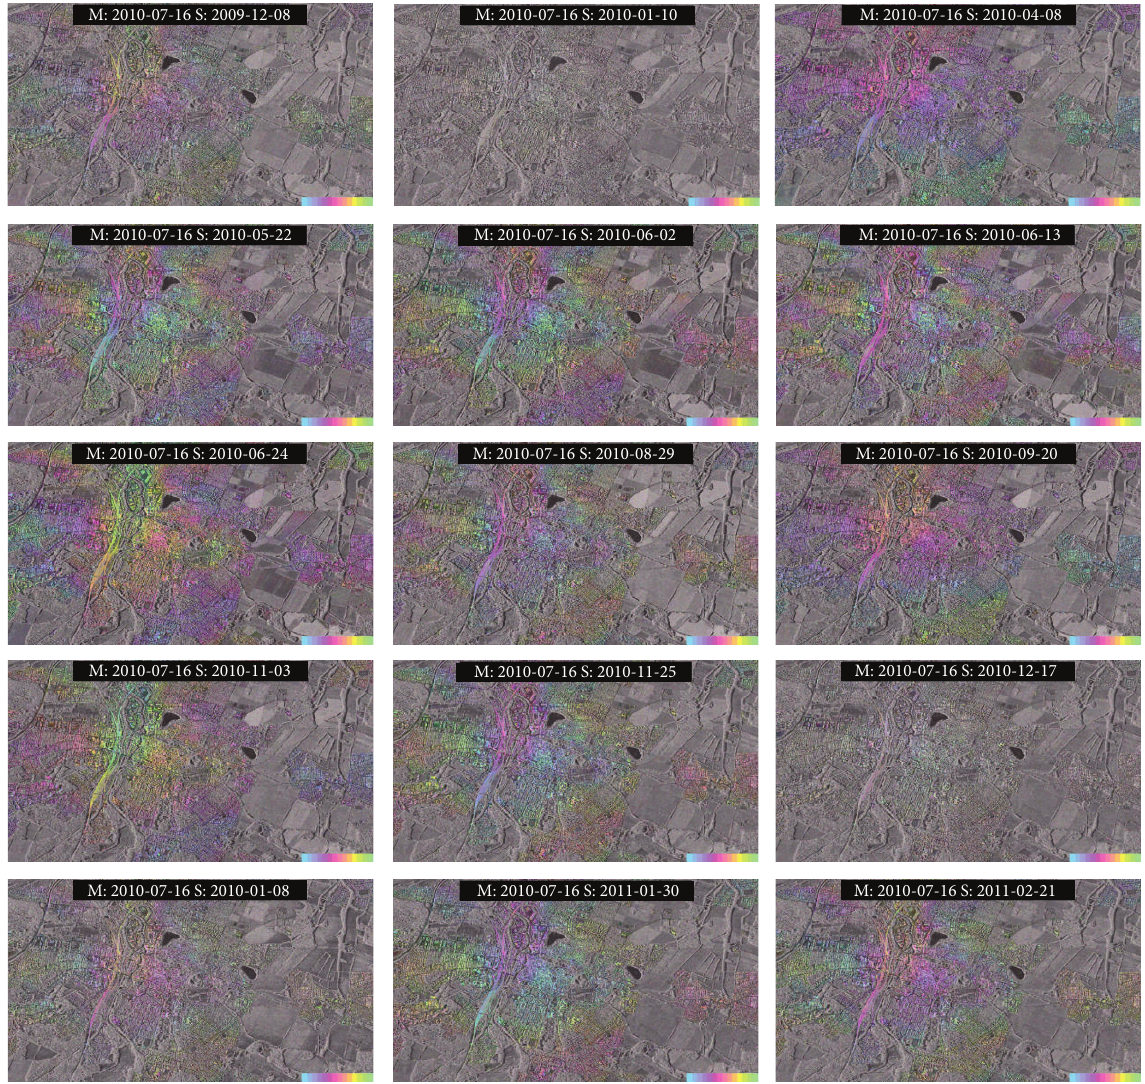
Figure 12: Time series of 15 full scene TerraSAR-X spotlight interferograms over L¨uneburg, Germany. The color intensity has been increased